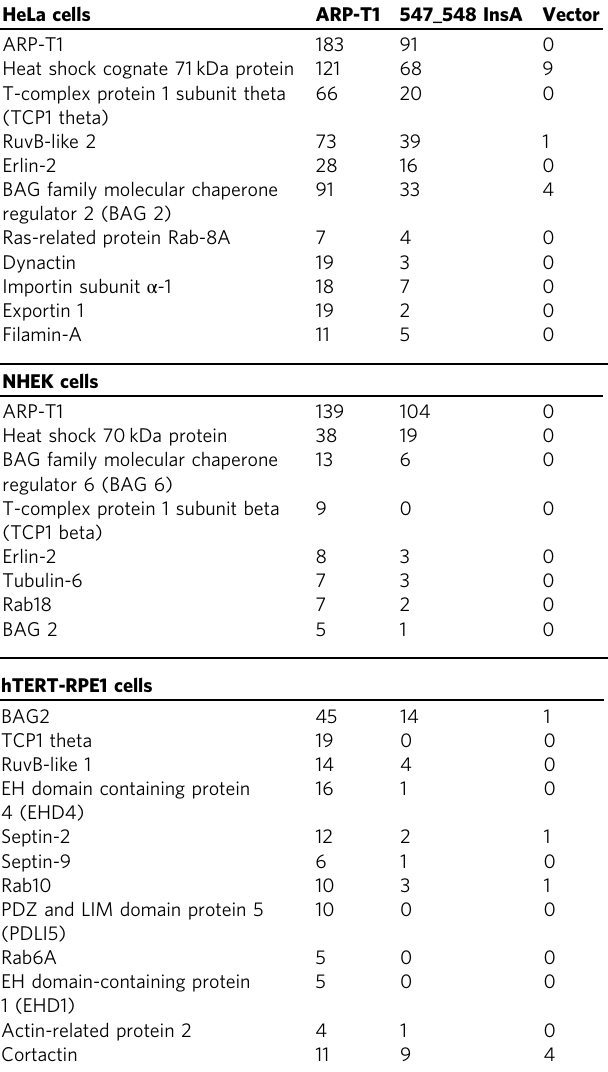
Table 1 Proteins interacting with